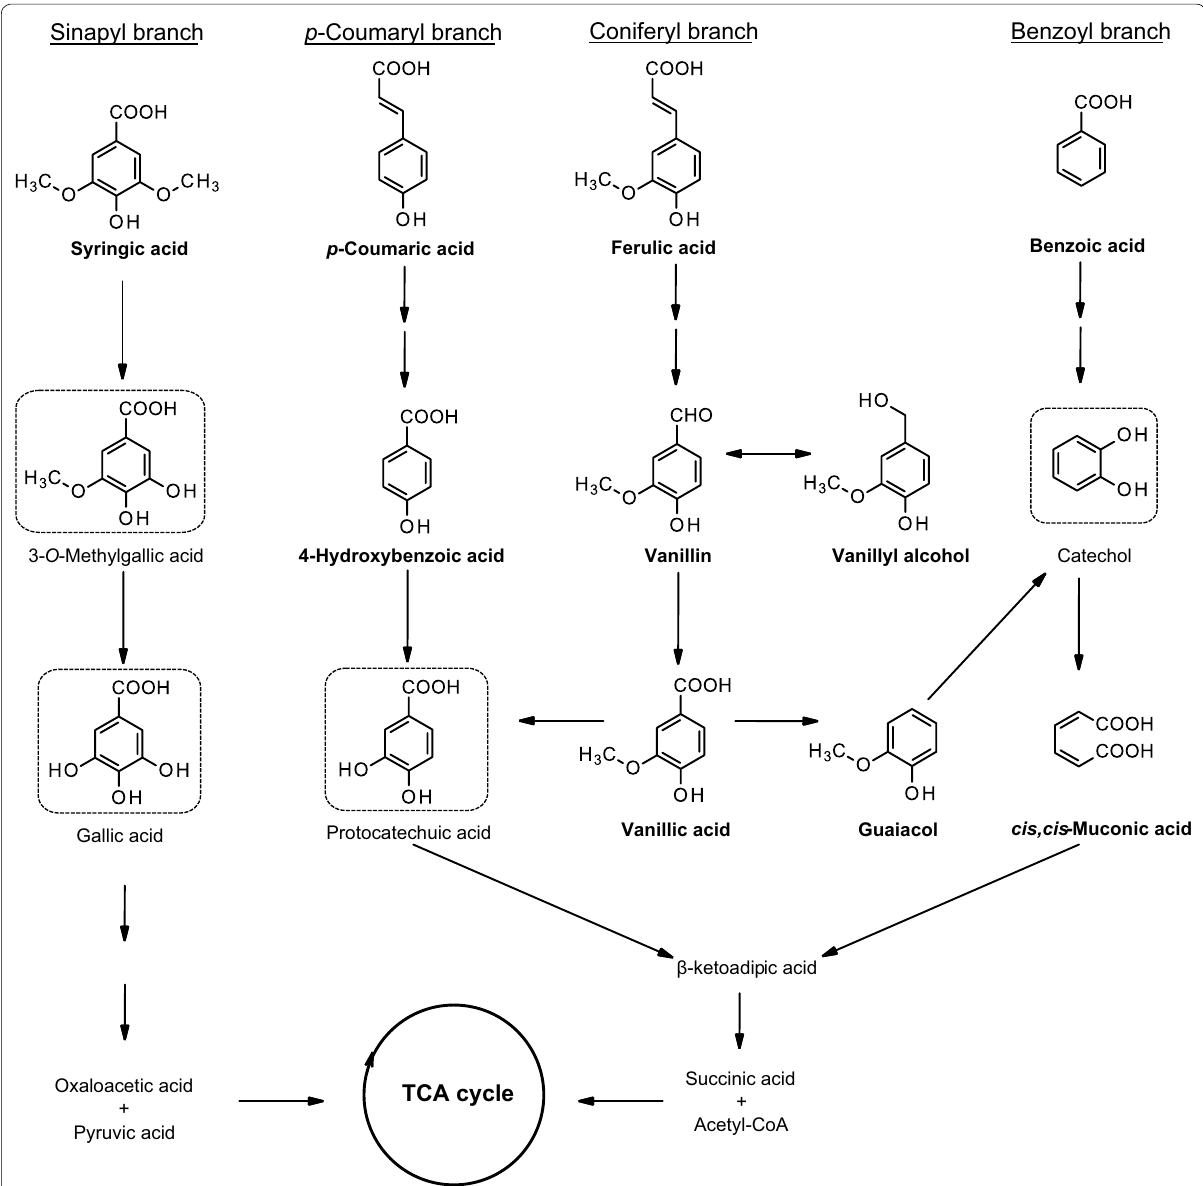
Fig. 1 Major upper funneling pathways for the bacterial metabolism of lignin model compounds. The model compounds used in this study are indicated in bold. Metabolic intermediates that can be subjected to aromatic ring cleavage are indicated in dashed